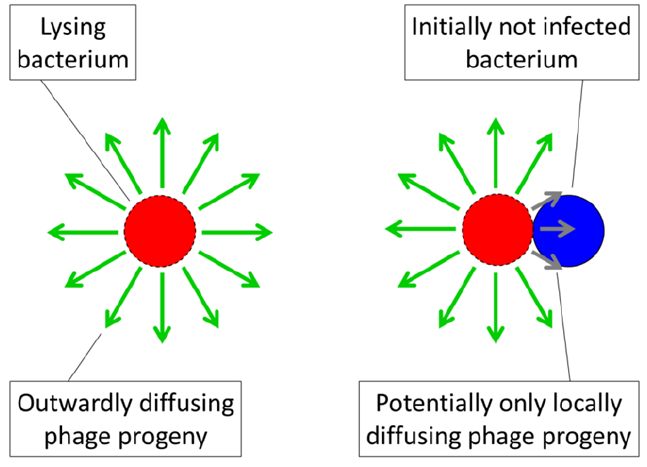
Figure 3. Illustration of the tendency of phages to display biases towards acquisition of locally available bacteria. Here shown to the right is phage acquisition of a bacterium (blue) that is found as part of the same arrangement as a lysing bacterium (red with dashed border). The green arrows represent outwardly diffusing phage progeny released upon bacterial lysis while the shorter, gray arrows illustrate the tendency of those phages that are released immediately adjacent to an uninfected bacterium to encounter that bacterium. Contrasting this second bacterium looming large in the vicinity of an adjacent phage burst, even at a high plankton bacterial density of 10 8 per mL, each free bacterium (left) occupies a total environmental volume of 10 4 µm 3 (1 cm = 10 4 µm, meaning that 1 mL = 1 cm 3 = 10 12 µm 3 , where 10 12 µm 3 /10 8 bacteria = 10 4 µm 3 /bacterium). This density in turn implies an average distance between bacteria of about 10 4/3 ( i.e. , the cube root of 10 4 µm 3 ), or more than 10 µm, which one may compare with a typical bacterium diameter of about 1